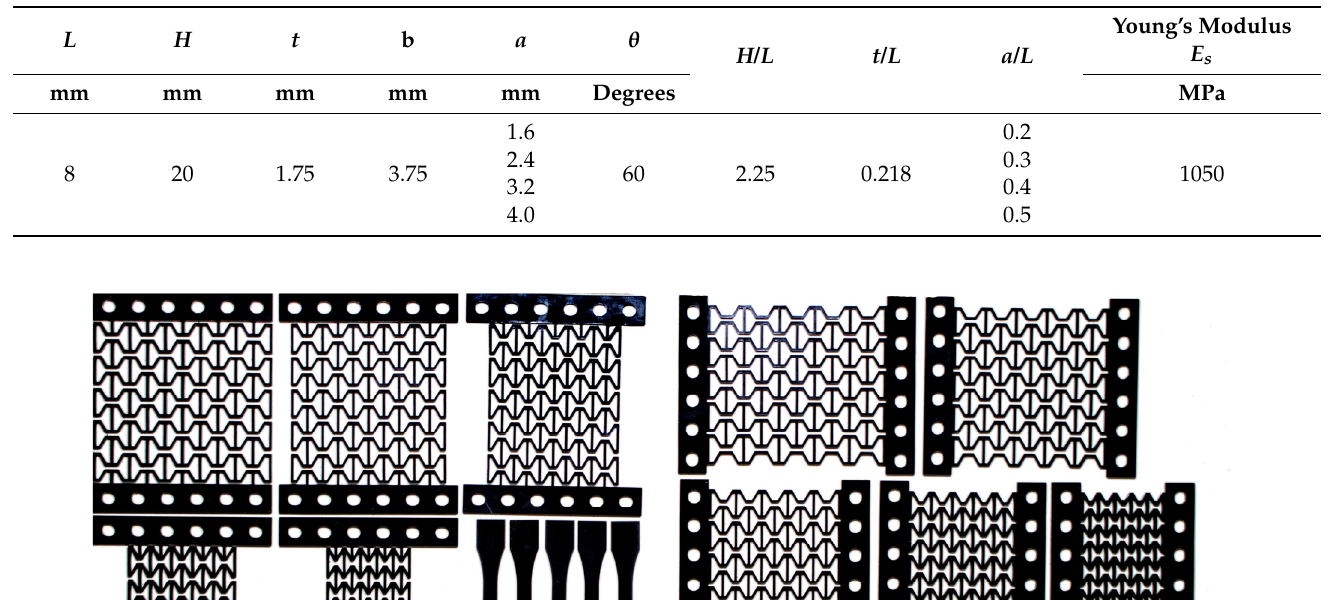
Figure 4. Boundary conditions for the FEA with points for measuring deflections. Table 1. Dimensions of the test samples.